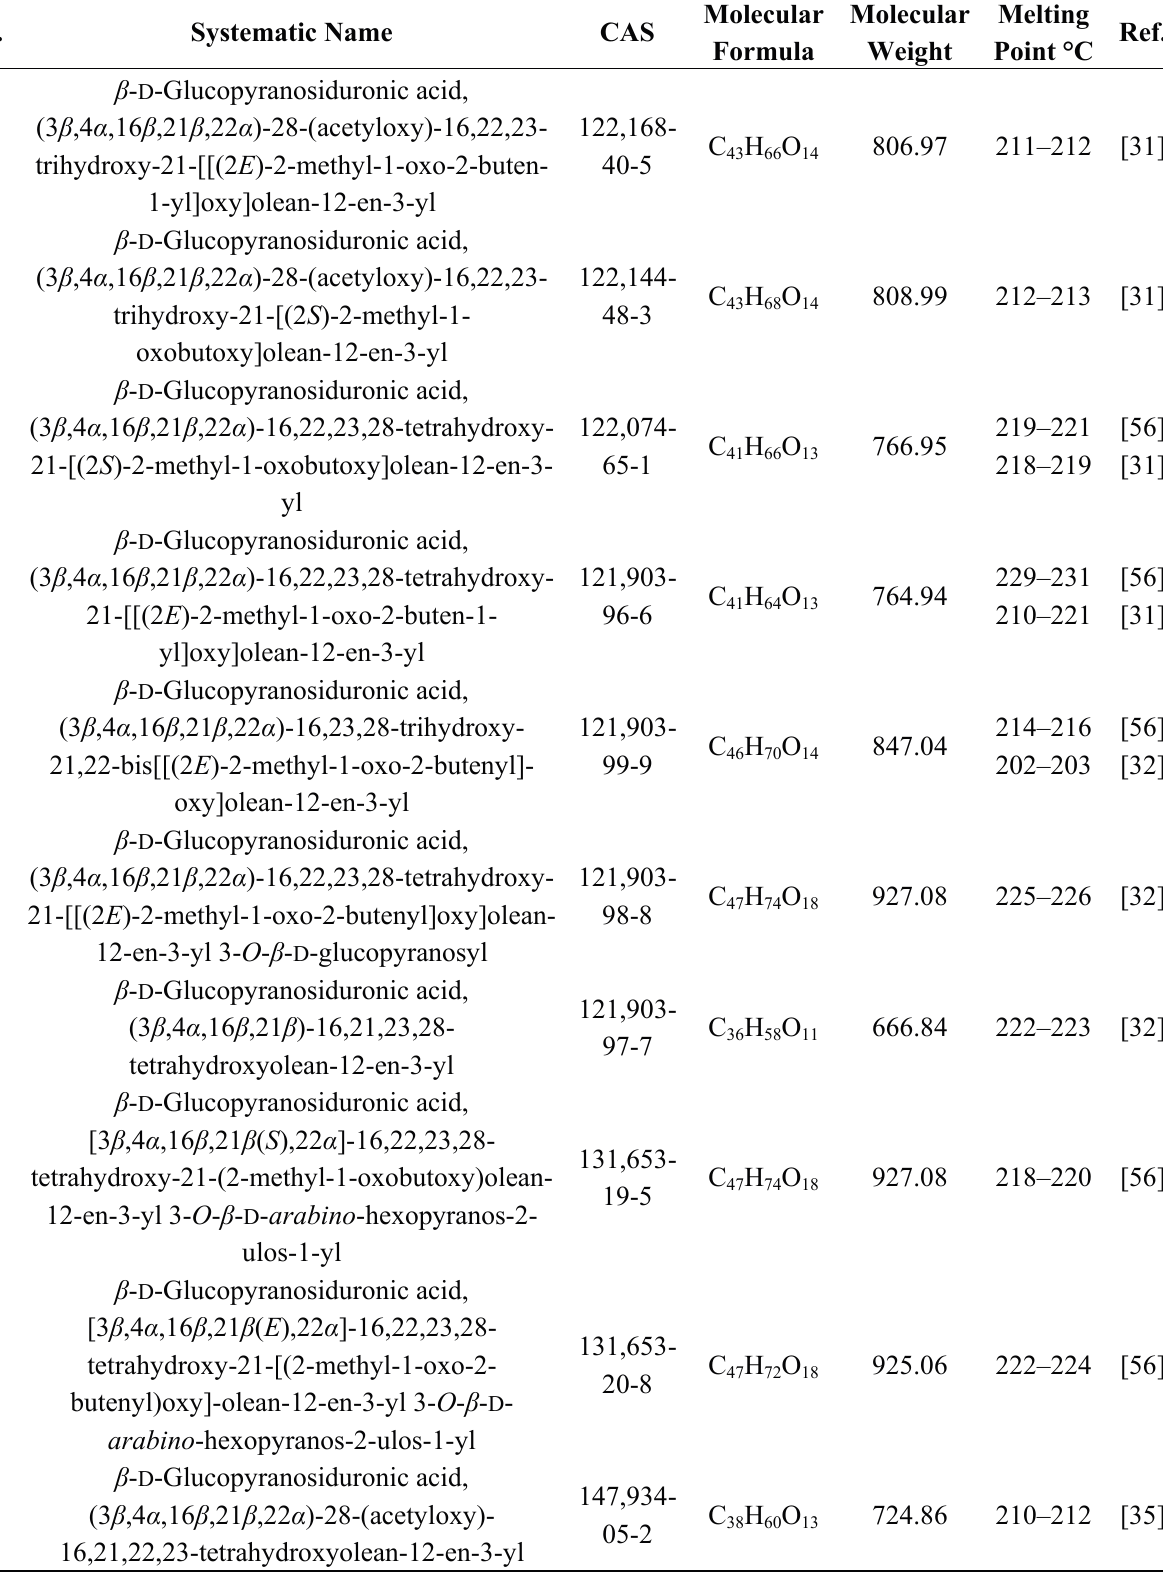
Table 3. Systematic names and physico-chemical characterization of triterpenes-1. No. Systematic Name CAS